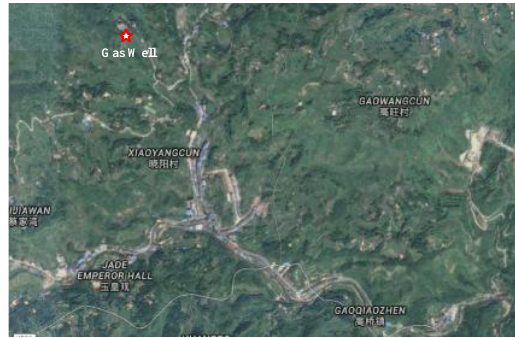
Figure 5 ． The location of gas well, villages and towns nearby (GOOGLE)